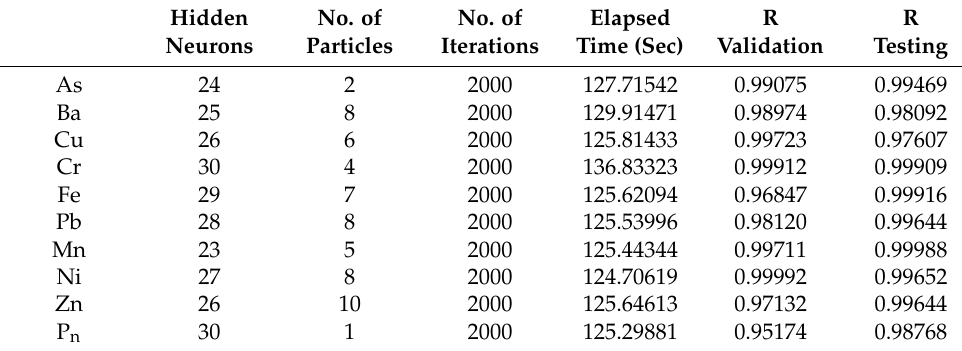
Table 4. NN-PSO Simulation Results for Soil Samples.